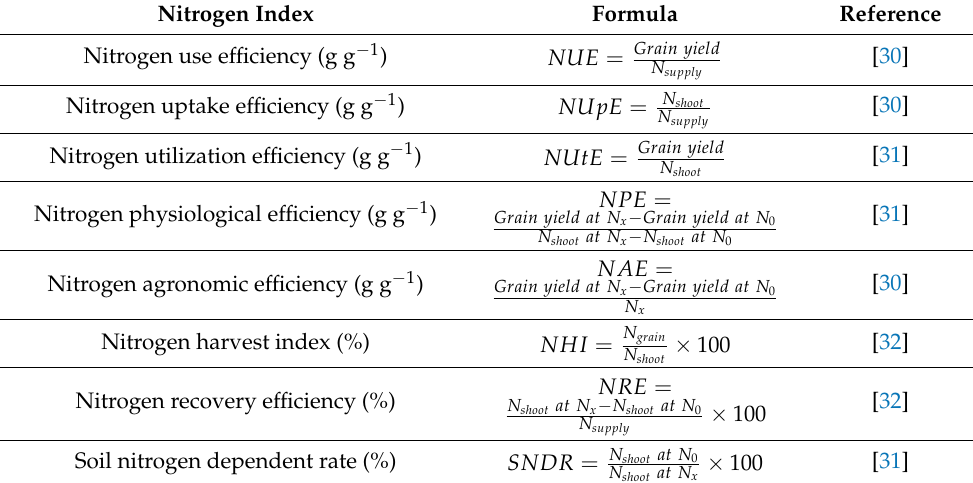
Table 2. Used formulas for nitrogen indices